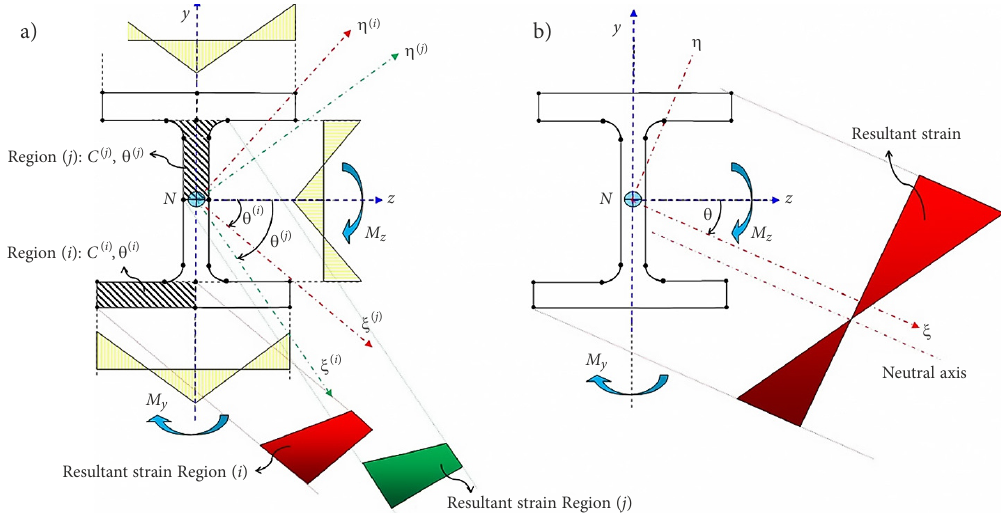
Fig. 5. Uniform stress distribution for encased steel profile. Rotation of the reference